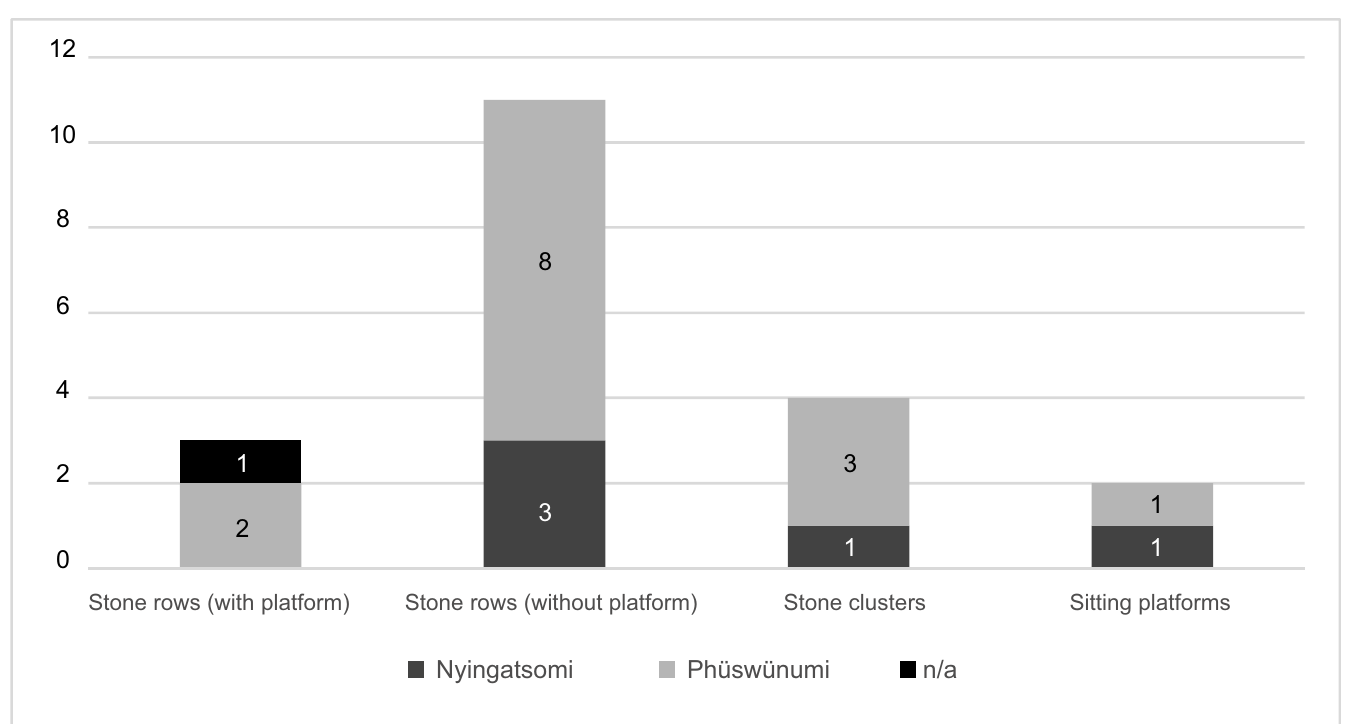
Sitting platformsStone clustersStone rows (with platform) Stone rows (without platform)